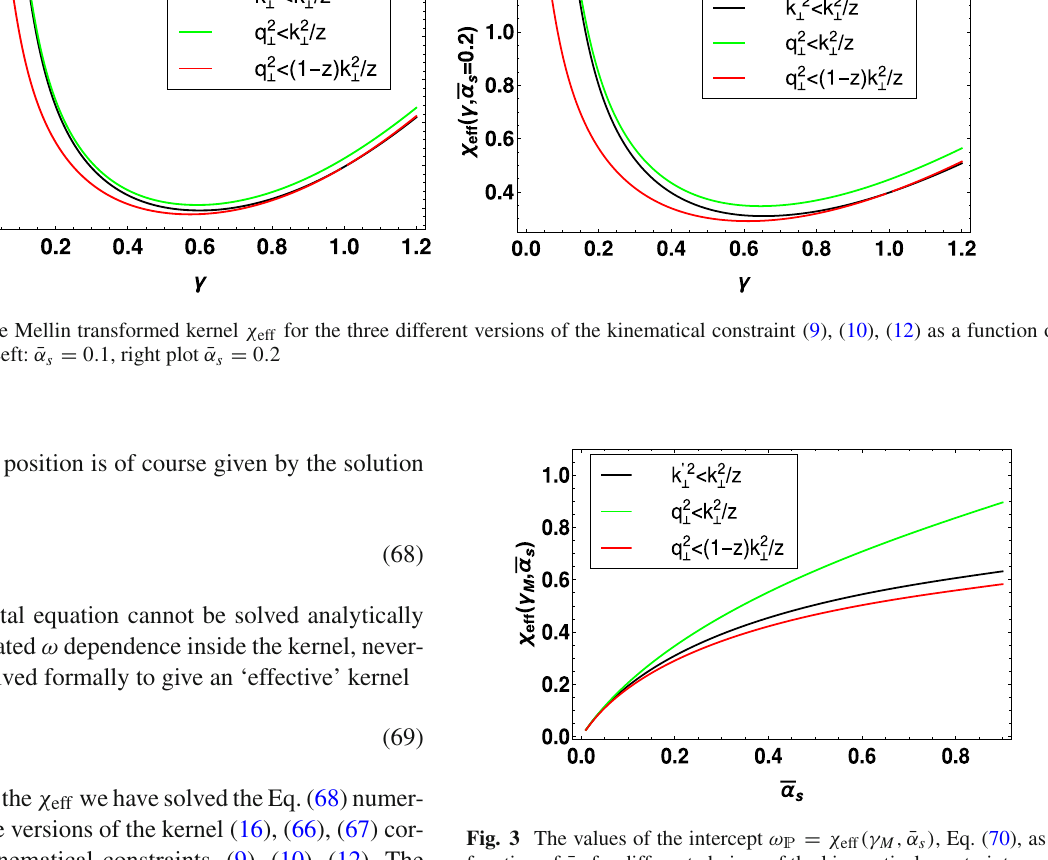
constraint (9) implies the restriction of the integration over collinear region as